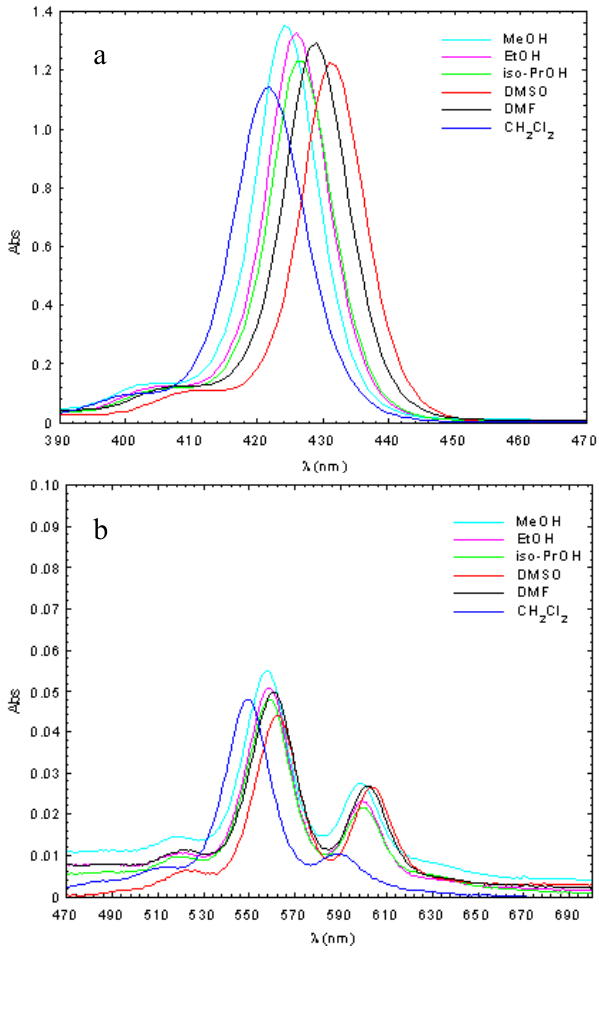
Figure 2. Absorption spectra of 5-(4-hydroxyphenyl)-10,15,20– tris -(4-carboxymethyl- phenyl) – 21, 23 Zn(II) porphine in different solvents (c = 2.5 × 10 − 6 M, a -Soret band; b -Q